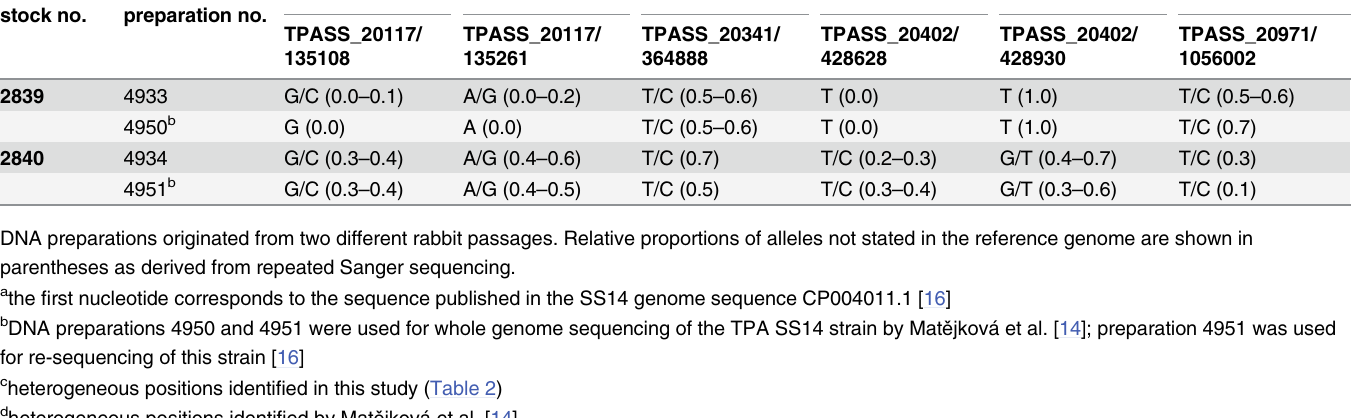
Table 3. Selected intrastrain heterogeneous sites identified in TPA SS14, examined in four different DNA preparations. Bact erial DNA G/C a, c, stock no. preparation no.